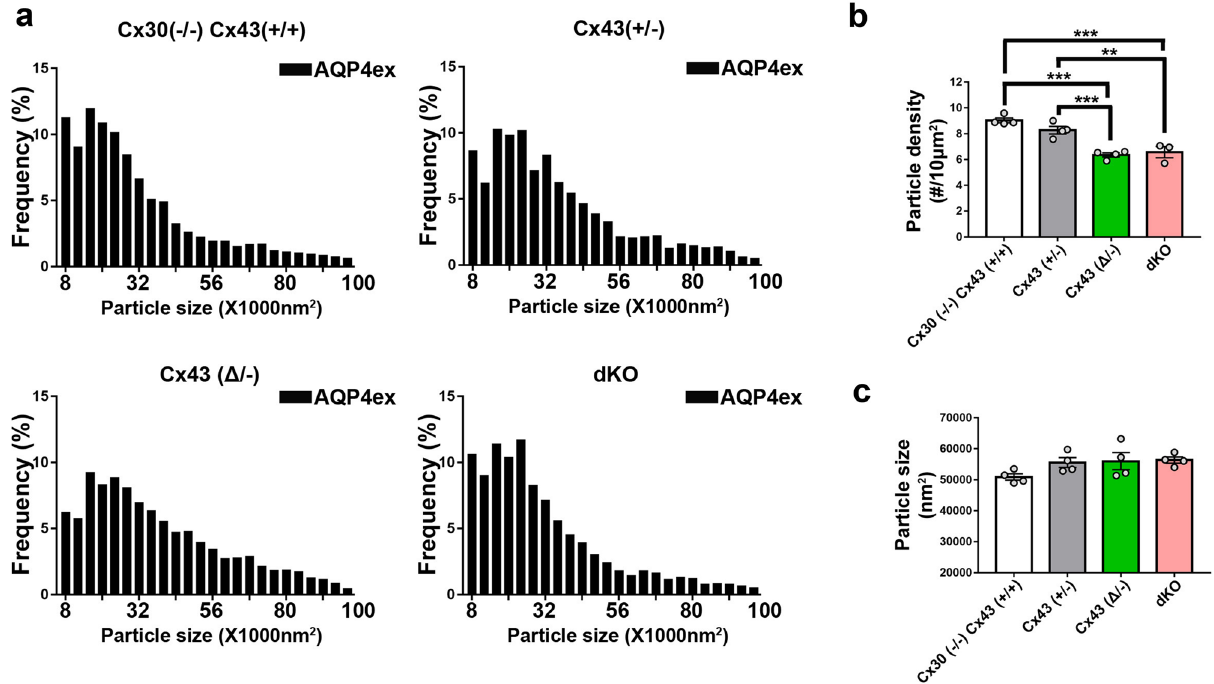
Figure 6. Expression of AQP4ex in astrocyte endfeet of transgenic mice. ( a ) Histograms showing size distributions of all AQP4ex particles measured in each genotype. (n = 4 mice, 6–10 images and 2000–3000 particles analyzed from each genotype). ( b ) Particle densities for AQP4ex in perivascular domains from each genotype. Dots represent four individual brains, from which 6–10 sections were analyzed. Note that particle number was higher in WT and Cx43 (+/−) than in the truncation mutant and dKO. ( c ) Sizes of the particles were relatively constant among the genotypes. Data are presented as mean ± SEM (ANOVA followed by Tukey’s post hoc test: * p < 0.05, ** p < 0.01, and *** p < 0.001.